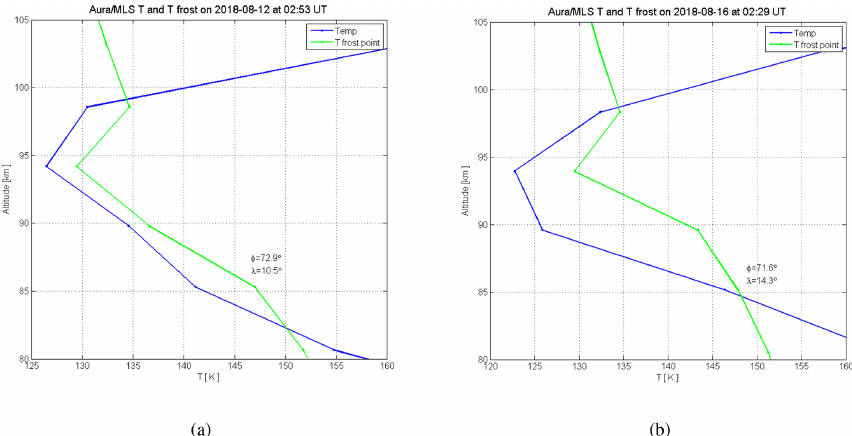
Figure 3. Temperature profiles (blue line) as measured by the Aura satellite at 12 and 16 August 2018 and frost-point temperature profiles (green line) estimated using the Aura water vapor data. Latitude and longitude of the measurement points are given in the figures by φ and λ respectively. Table 1. Parameters for EISCAT VHF radar operation and EISCAT heating facility. Half of the VHF antenna is used for transmitting, and the entire antenna is used for receiving (beamwidth adjusted